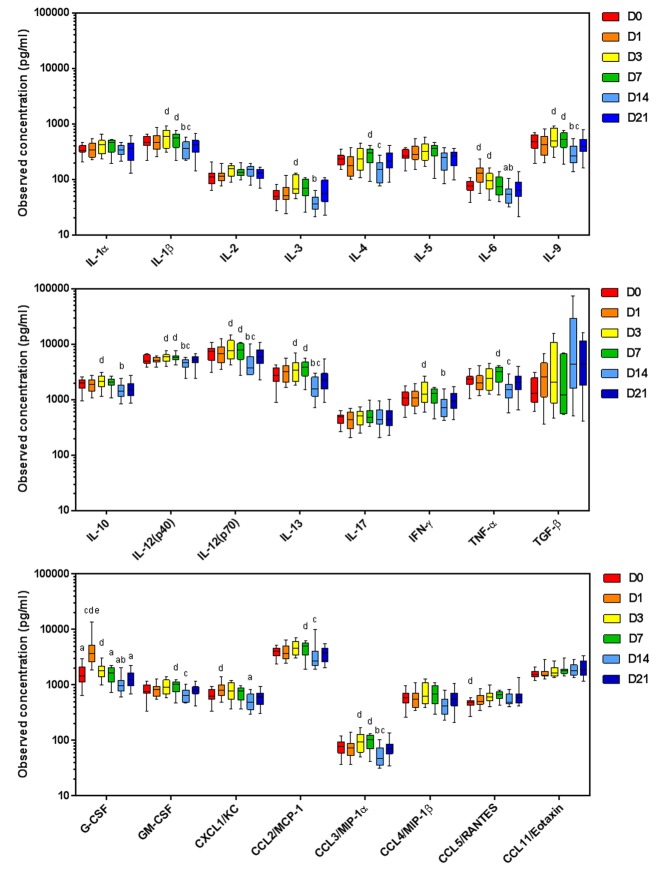
Plasma cytokine and chemokines levels from mice inoculated with glioma Gl261 cells.Plasma was harvested at day 0 (sham) to day 21 time points and assessed by 23-plex immunoassay, except TGF-β1 (by chromogenic ELISA). Data are expressed as observed concentration in pg/ml. ap<0.05 vs D14; bp<0.05 vs D21; cp<0.05 vs D7; dp<0.05 vs D3; ep<0.05 vs D1 by Dunn’s Multiple Comparison Test.